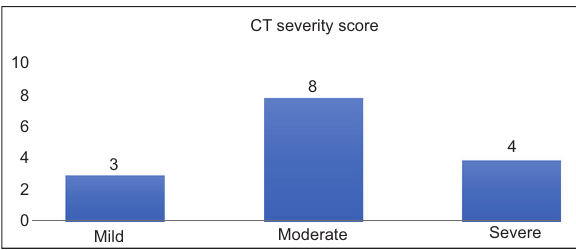
Figure 3: CT severity